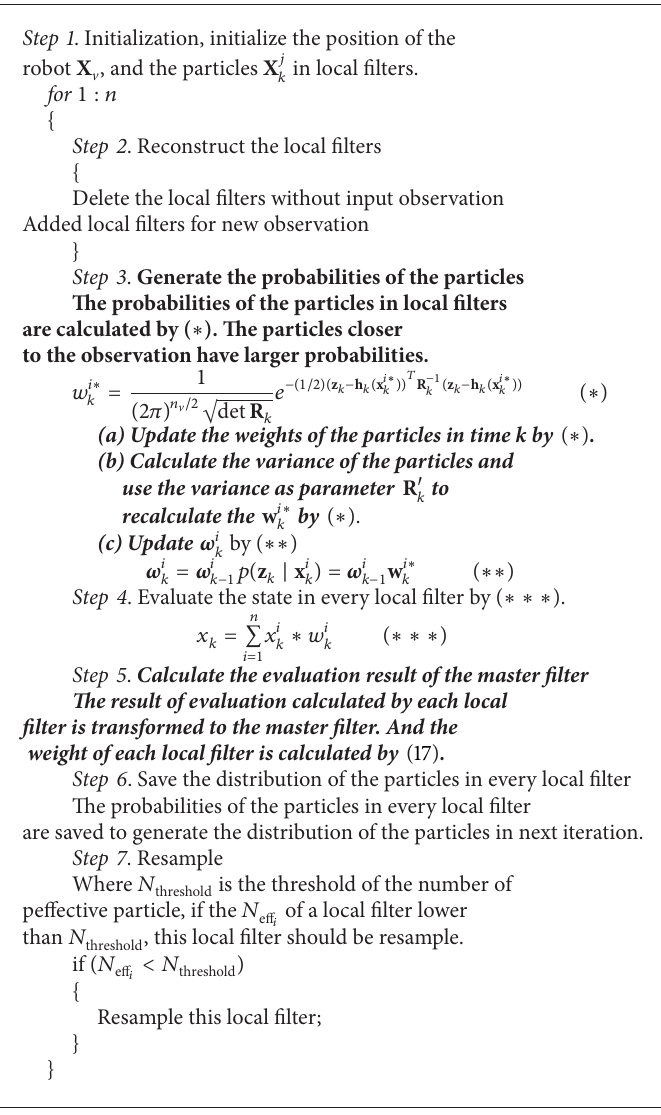
Algorithm 1: Improved distributed particle filter (Improved